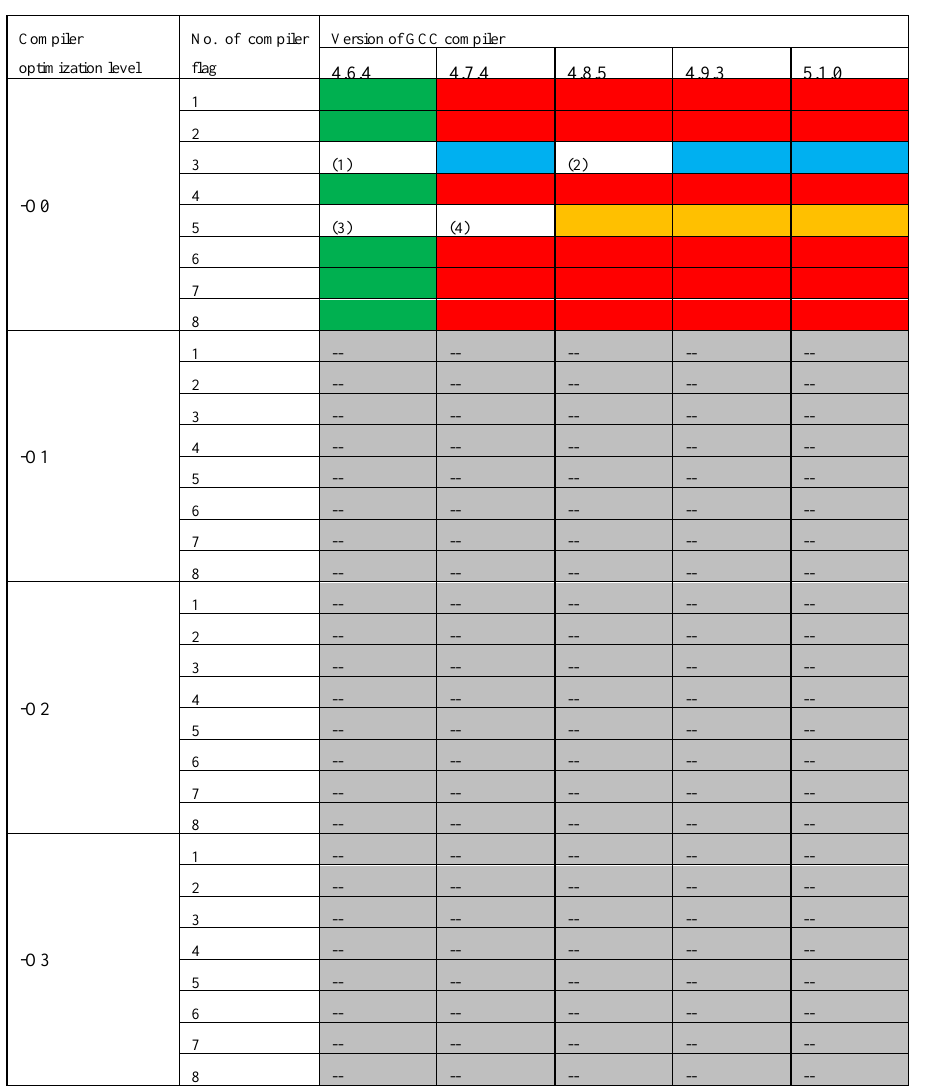
Table 13: Similar to Table 11 except for the simulation results of FGOALS-g2. FGOALS-g2 1 has not been compiled using the GCC compilers for simulation runs before. Therefore a large 2 Table 13. Similar to Table 11 except for the simulation results of FGOALS-g2. FGOALS-g2 has not been compiled using the GCC compilers proportion of simulation runs are failed (marked with "--" in the table). For example, crashes or 3 for simulation runs before. Therefore, a large proportion of simulation runs are failed (marked with “–” in the table). For example, crashes or deadlocks are encountered under compiler optimization levels O1 to O3. deadlocks are encountered under compiler optimization levels O1 to O3.